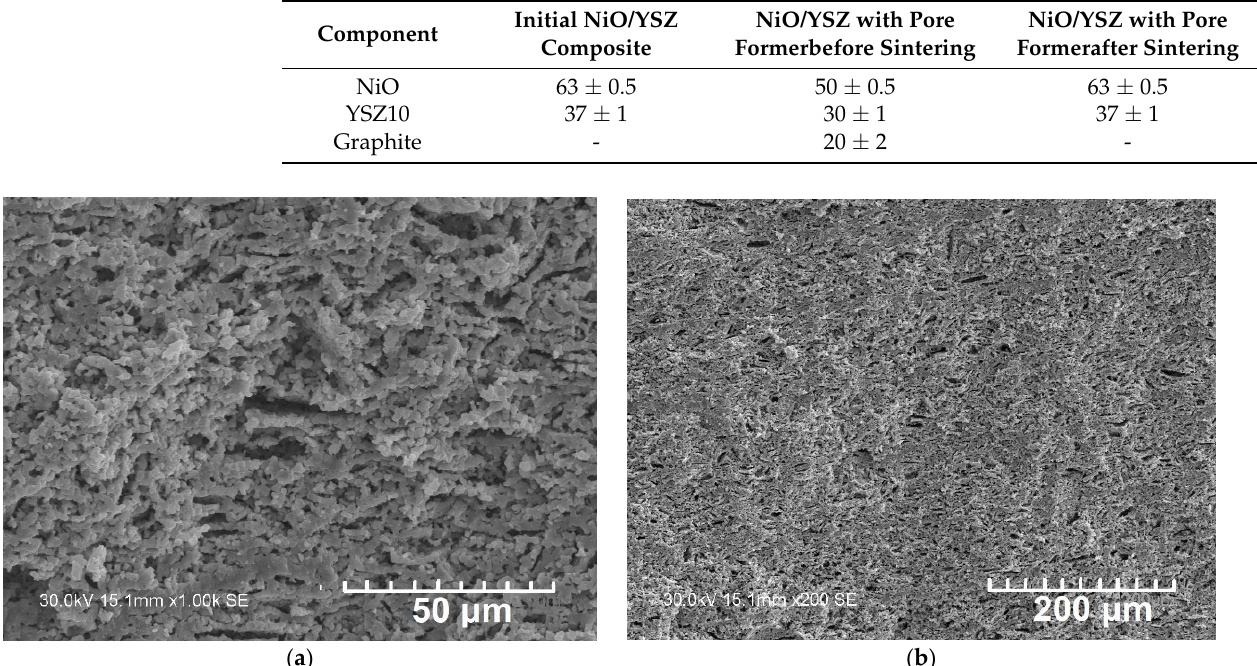
graphite (2), and the printed sample after sintering (3).